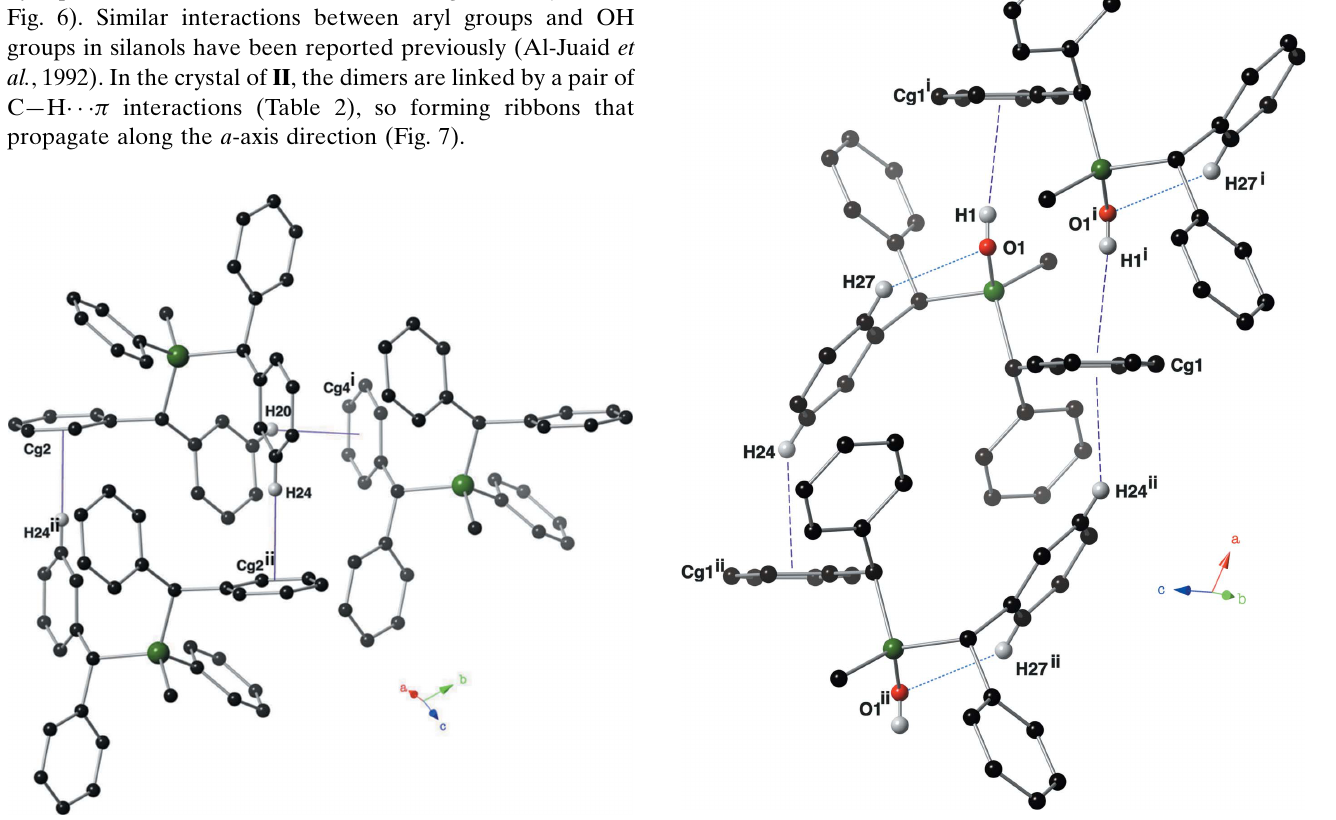
Figure 6 Intramolecular hydrogen bond (blue dotted lines) and intermolecular C—H (cid:2)(cid:2)(cid:2) (cid:2) and O—H (cid:2)(cid:2)(cid:2) (cid:2) interactions (Table 2; purple dashed lines) present in the crystal of compound II . For clarity, only hydrogen atoms H1, H24 and H27 have been included. Symmetry codes: (i) (cid:4) x + 1, (cid:4) y + 1, (cid:4) z ; (ii) (cid:4) x , (cid:4) y + 1, (cid:4) z